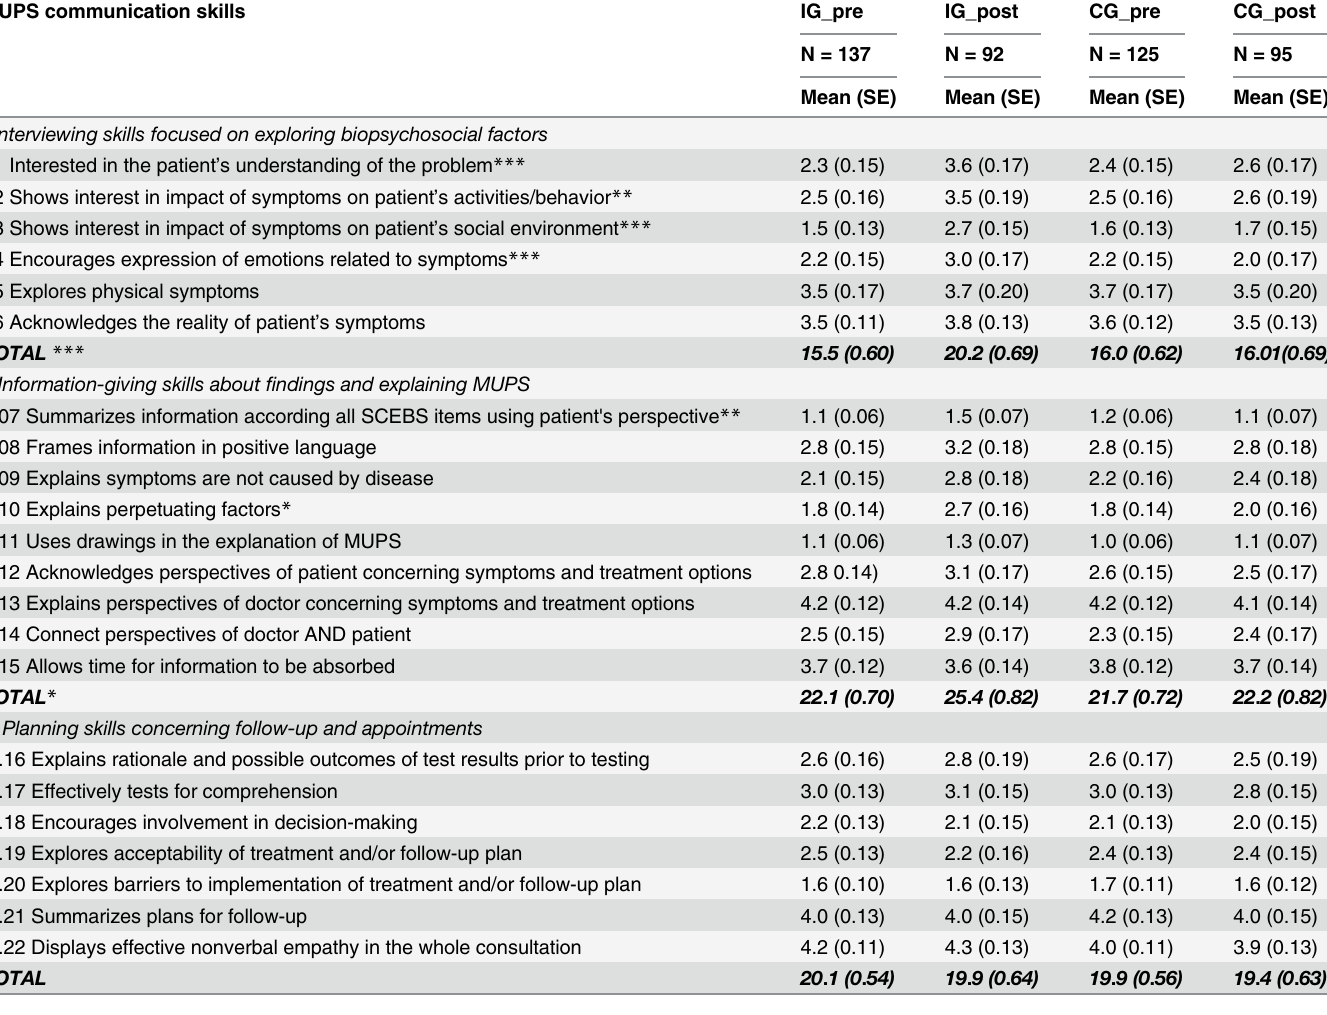
Table 4. Effects on doctors ’ communication skills. Estimated marginal means on scale range 1 – 5; 1 = min., 5 = max. score. Intervention group = IG, Con- trol group = CG, pre = pre-measurement, post = post-measurement. P-value contrast: ‘ IG post-training minus IG pre-training ’ compared to ‘ CG post-training minus CG pre-training